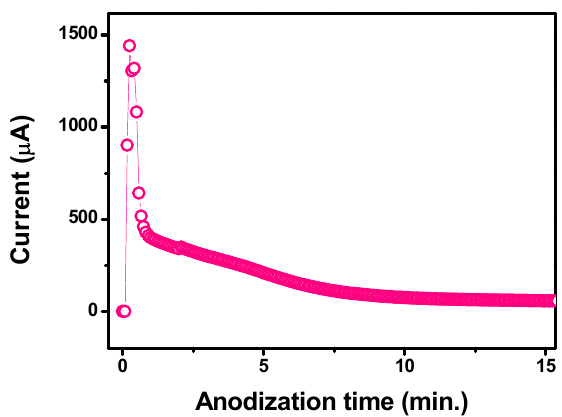
Figure 2. Current–time curve obtained during anodic oxidation of the Ti working electrode.